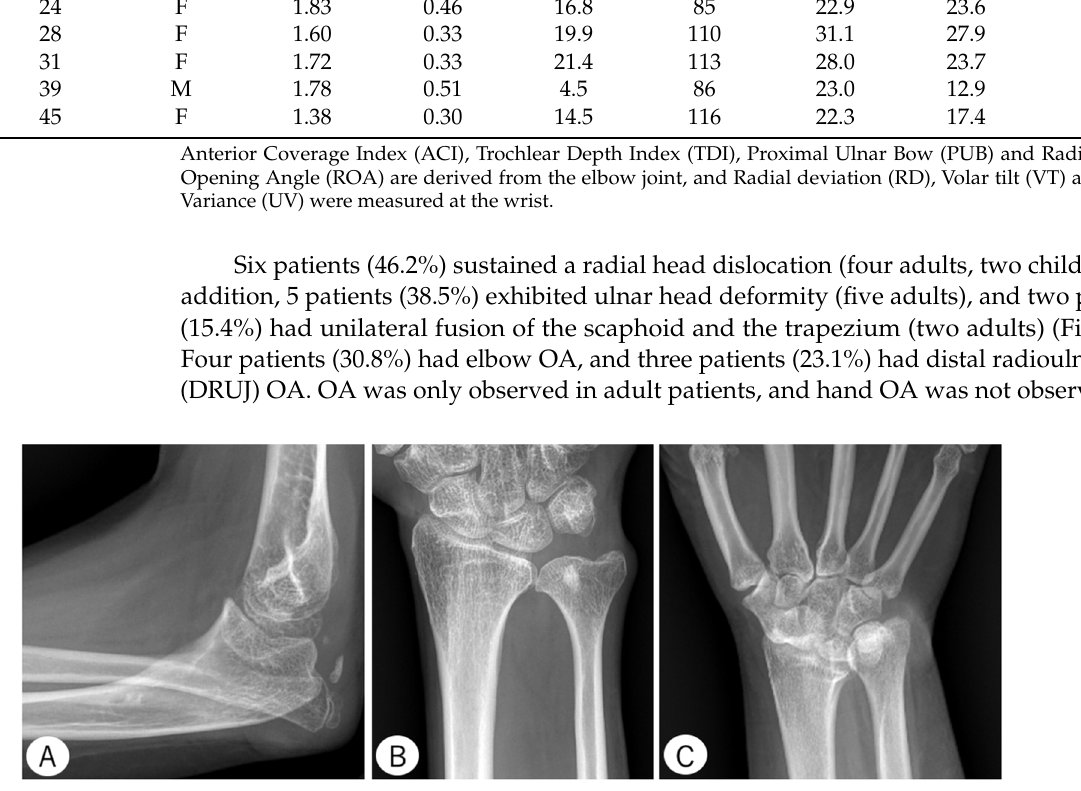
Figure 4. Radiographs of example cases. Patient 3 at age 11 years shows an angularly deformed proximal ulna and posteriorly dislocated radial head ( A ). Patient 12 at age 39 years shows a narrow ulnar diaphysis and an enlarged distal area ( B ). Patient 11 at age 31 years shows a fused scaphoid and trapezium ( C ).